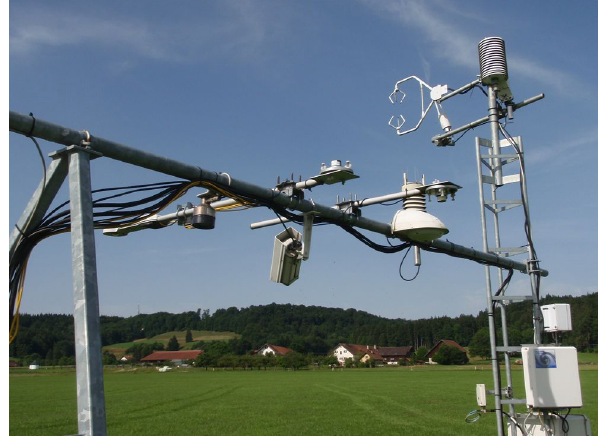
Figure 4. Photograph of the eddy-covariance system at DE-Fen grassland site. The hill in the background has a height of about 100m compared to the grassland in the foreground (photograph by Matthias Mauder).